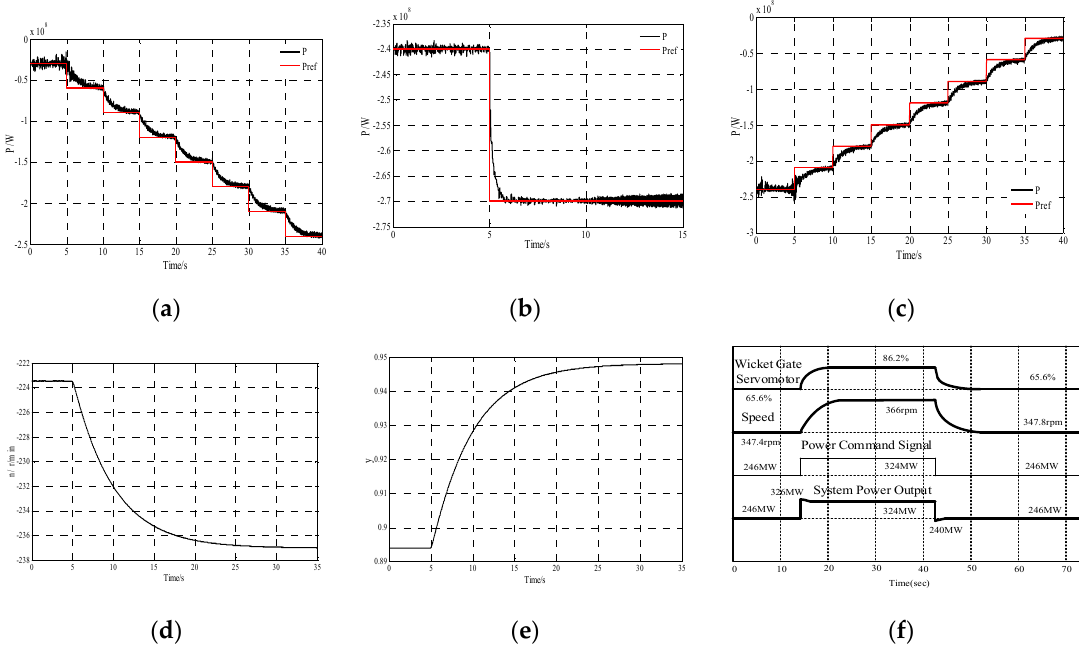
Figure 14. Simulation waveforms of unit in pump mode: ( a ) active power in load ramping stage; ( b ) active power in stable operation stage; ( c ) active power in load rejection stage; ( d ) speed in stable operation stage; ( e ) guide vane opening in stable operation stage; ( f ) actual dynamic responses for a DFVSPS unit in stable operation.